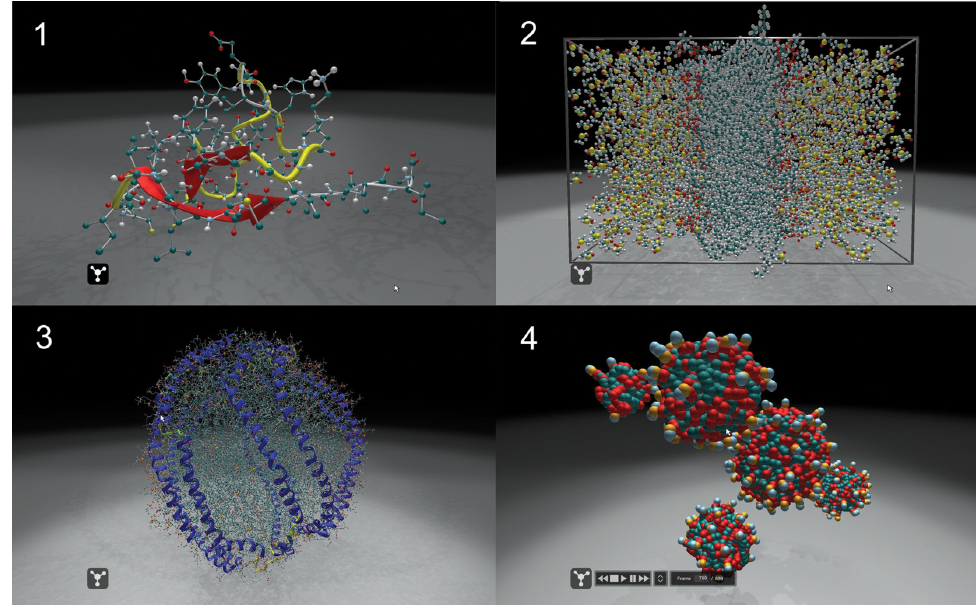
Figure 5: Biomolecular systems used to test the capability of the application: (1) the conformational dynamics of an intrin- sically disordered protein; (2) the interactions of a model cell membrane with an aqueous solution of small molecules;